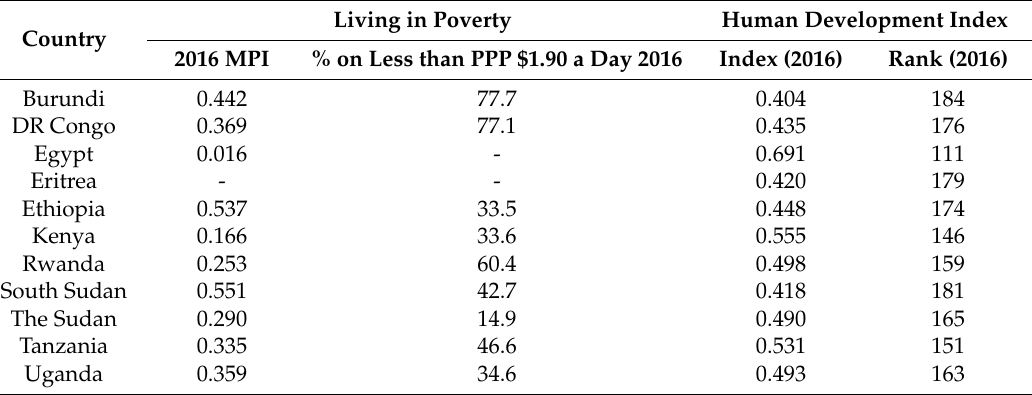
Table 3. Nile Basin demographics (poverty levels and Human Development Index). Source: NBI (2012) for the 2011 unconstrained energy deficit per country ([24], p. 169). 2016 United Nations Development Programme (UNDP), Human Development Report (HDR) for 2015 for data on the percentage of population living in poverty, the Multidimensional Poverty Index (MPI) and the Human Development Index (HDI) and rank [46]. There was no data available in the 2016 UNDP HDR for Eritrea and Egypt PPP and Eritrea MPI. Living in Poverty Human Development Index Country 2016 MPI % on Less than PPP $1.90 a Day 2016 Index (2016) Rank (2016)